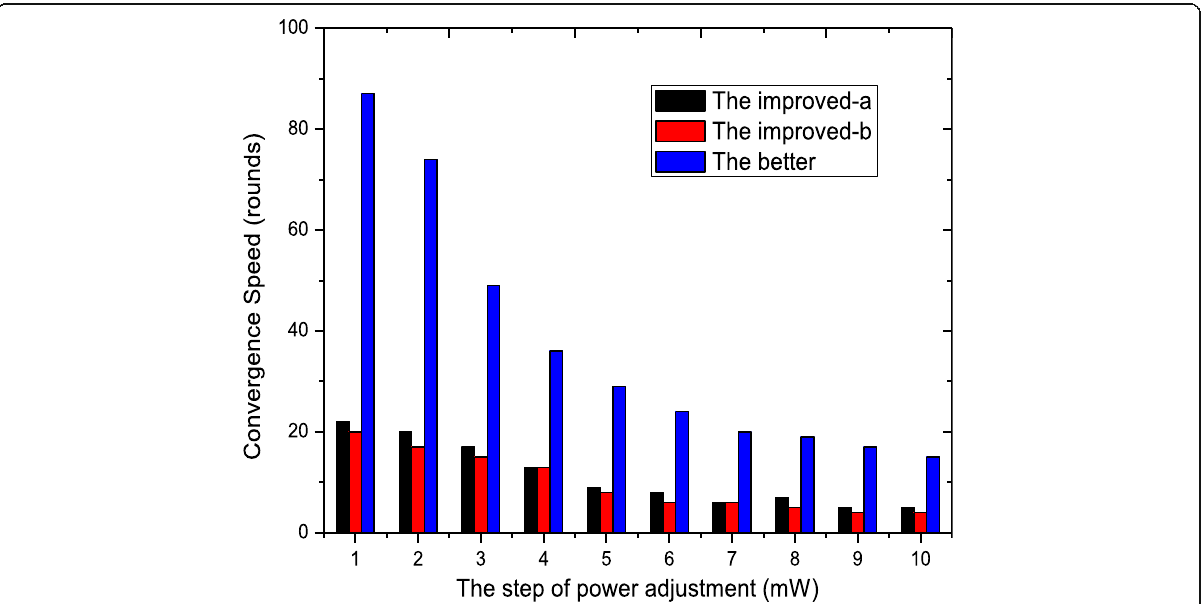
Fig. 18 Convergence performance comparison: variation trend of convergence time of TOM-PAOD with the step size for power adjustment, in which the different game decision algorithms are adopted